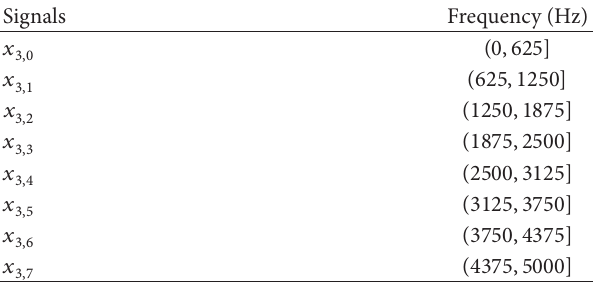
Table 2: Frequency intervals of eight subfrequency